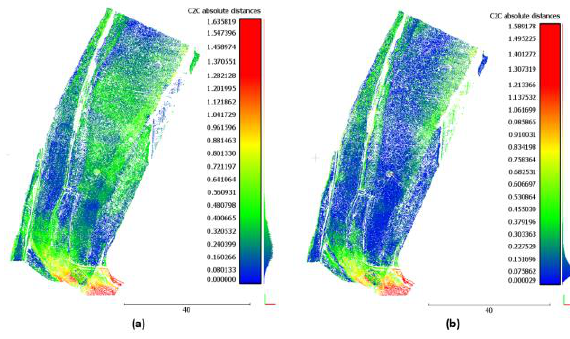
Figure 29. The nearest neighbor C2C distance computation results – (a) C2C result from the MBBC registration output,